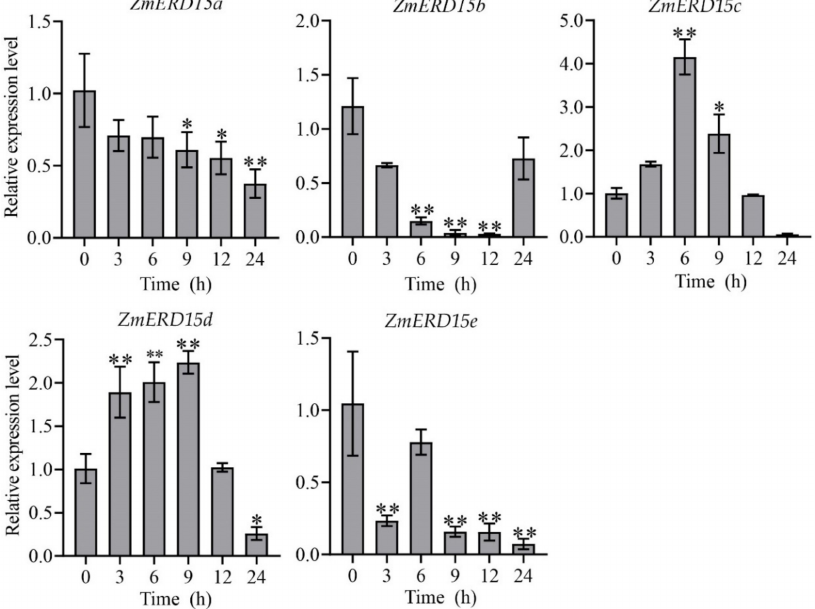
Figure 6. Expression of ZmERD15s in response to salinity. The seedlings were subjected to 100 mM NaCl for saline stress. * and ** indicate significant differences from the level of expression at time 0 at p < 0.05 and p < 0.01,